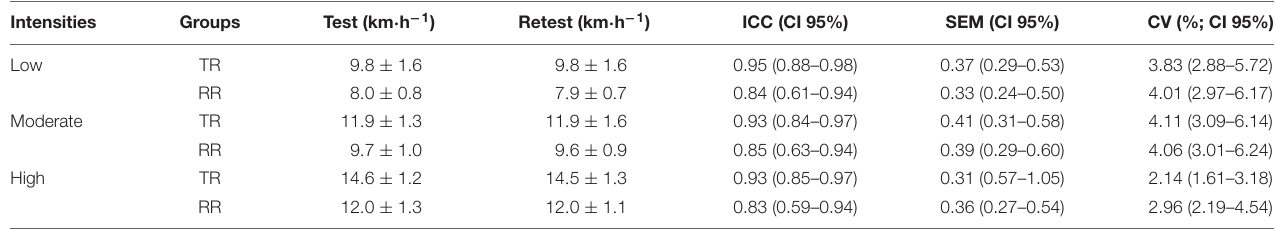
FIGURE 1 | Bland-Altman plot of V peak _ TF1 vs., V peak_TF2 , for trained runners (TR; A) , recreational runners (RR; B) , and all runners (C) . Dotted lines represent the bias and solid lines denote lower and upper 95% limits of agreement. TABLE 3 | Reliability of the submaximal intensities corresponding to low (70%HR max ), moderate (80%HR max ), and high intensities (90%HR max ) obtained during the test to V peak _ TF for trained runners (TR) and recreational runners